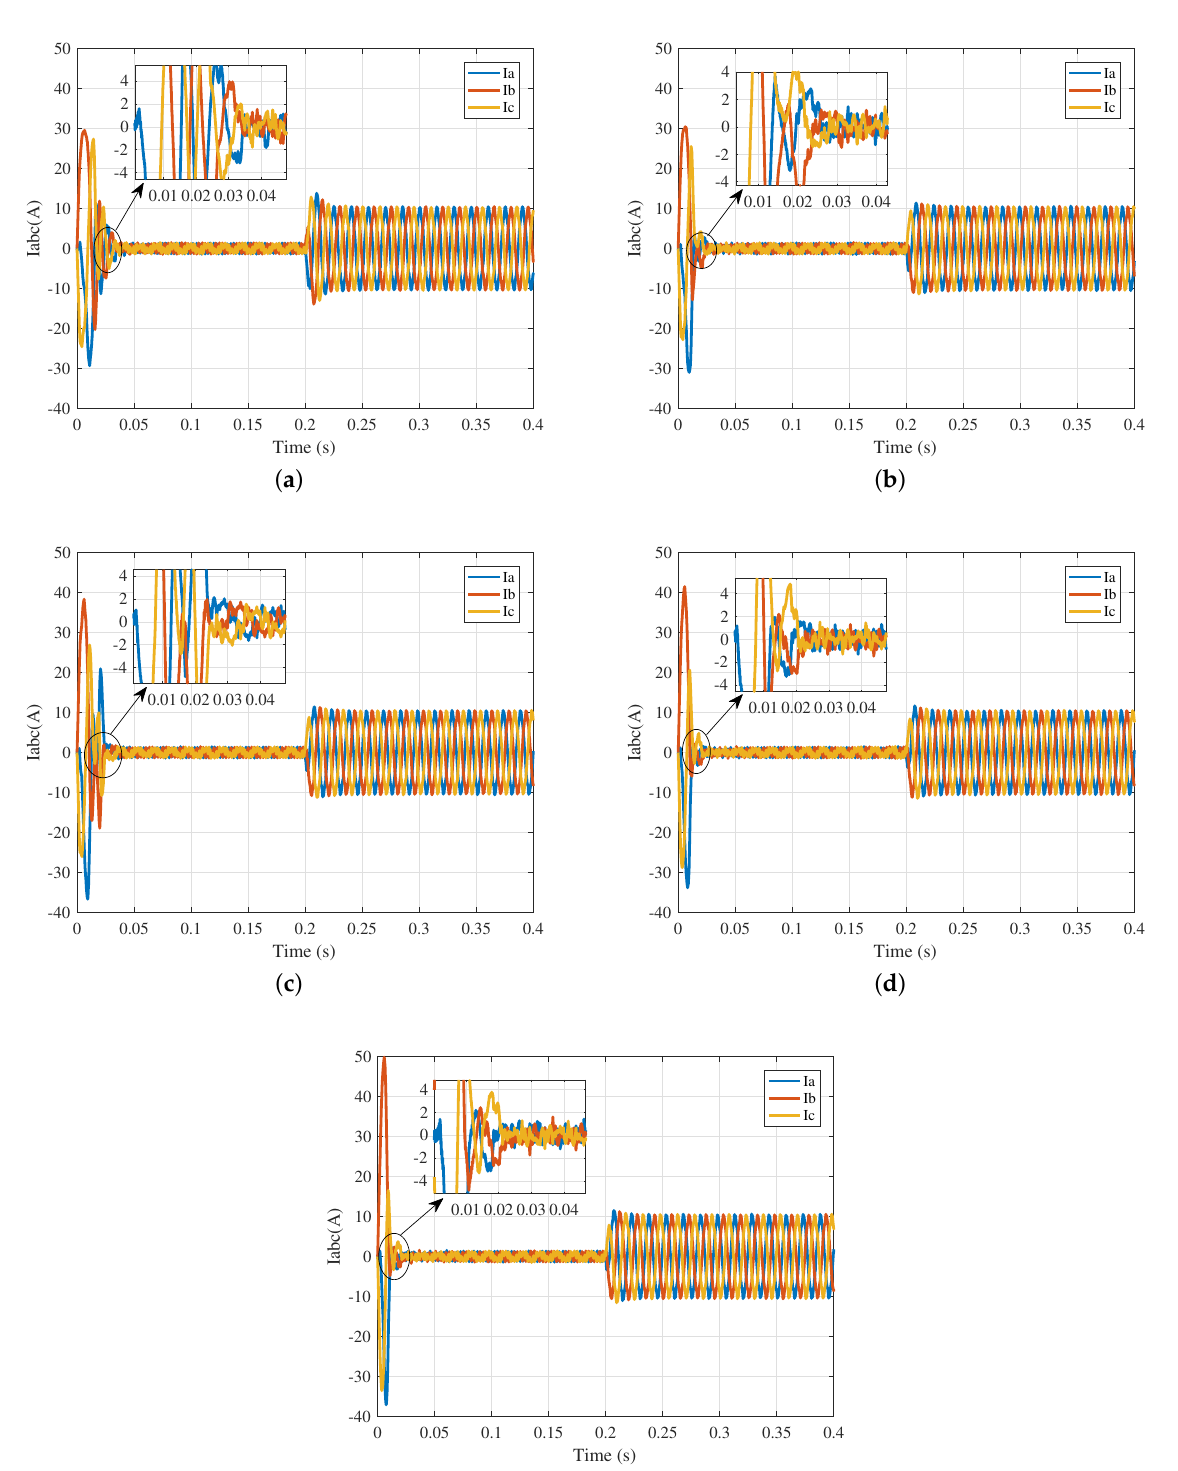
Figure 17. Three-phase current variation curves. ( a ) PI; ( b ) FDPI; ( c ) FDPI-HT; ( d ) FDPI-T1FDHT; ( e )